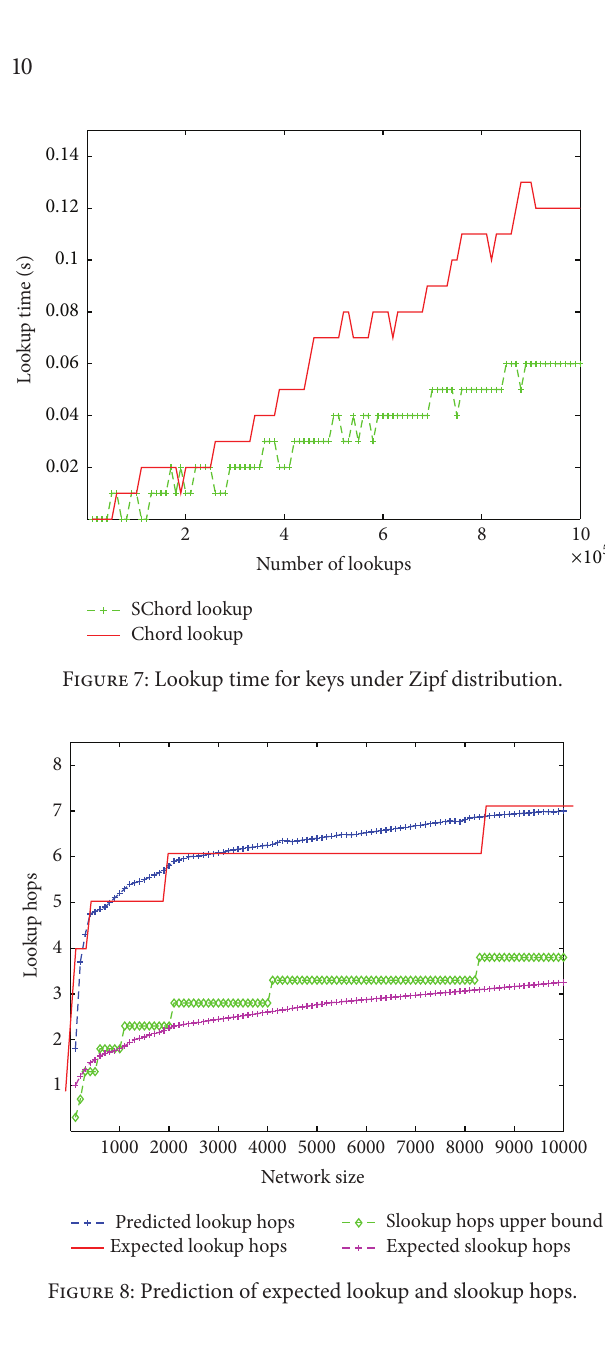
Figure 10: Hops reduced by